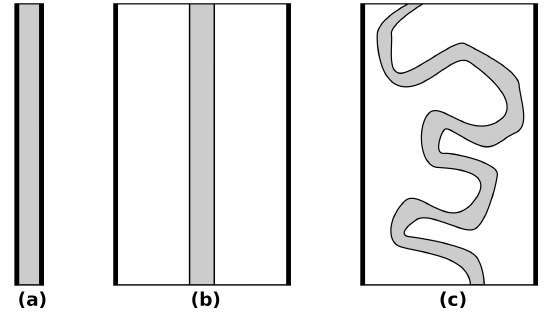
Figure B1. Our equations for sediment transport follow the river, but geomorphic evolution occurs along valley networks. In some cases (a) , these are perfectly aligned and have the same width. How- ever, if the river is aggrading and the valley walls are not vertical, and/or the river is eroding its valley walls at a rate that is comparable to or faster than its rate of vertical incision, (b) the river may carve a valley that is wider than its channel. (Here, the channel is pictured in the center, but it need not be positioned there.) In creating a wide valley, the river may move laterally, leading to (c) downstream and down-valley flow directions that are not aligned. While this depicts a single-thread channel, this same differentiation between channels and valleys is applicable to multi-thread channels.